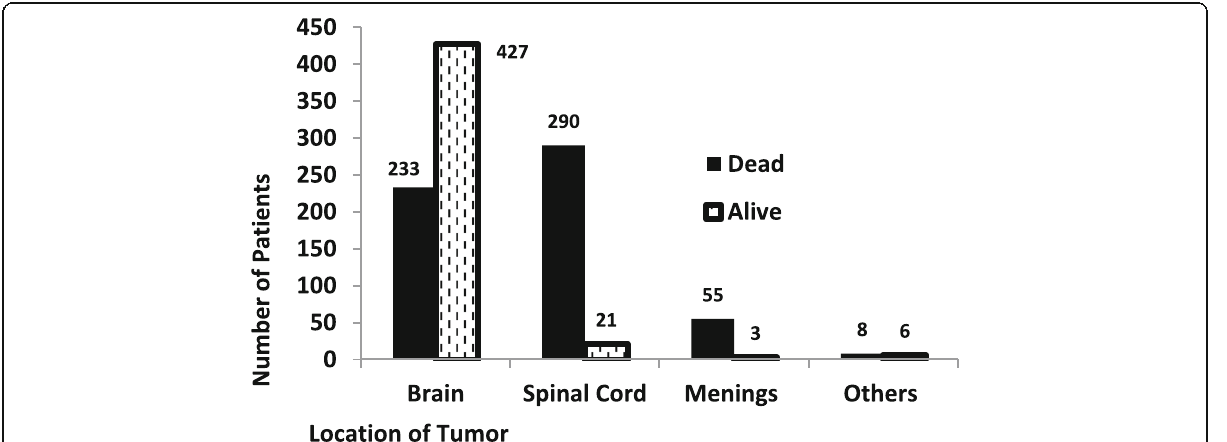
Fig 3 Frequency of tumors (dead/alive) according to the reported sites in total population